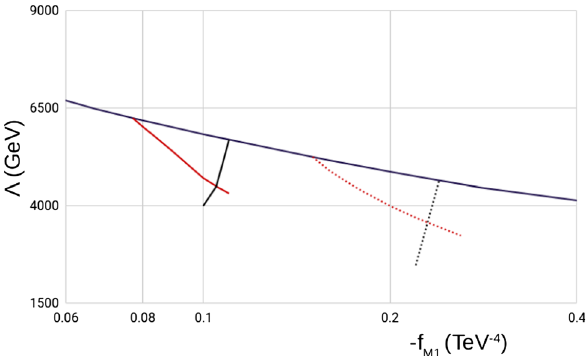
Fig. 4 Regionsinthe (cid:2) vs f (negative f values)spacefor M 1operator in which a 5 σ BSM signal can be observed and the EFT is applicable. The unitarity limit is shown in blue; the lower limits for a 5 σ signal significance from Eq. (2.3) (red) and the upper limit on 2 σ EFT consis- tency (black). The solid (dotted) lines correspond to 15 ab − 1 (3 ab − 1 ). √ s = 27 Assumed is